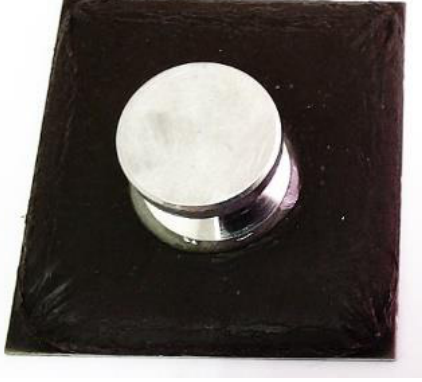
Figure 2. Dolly applied on the coating surface.